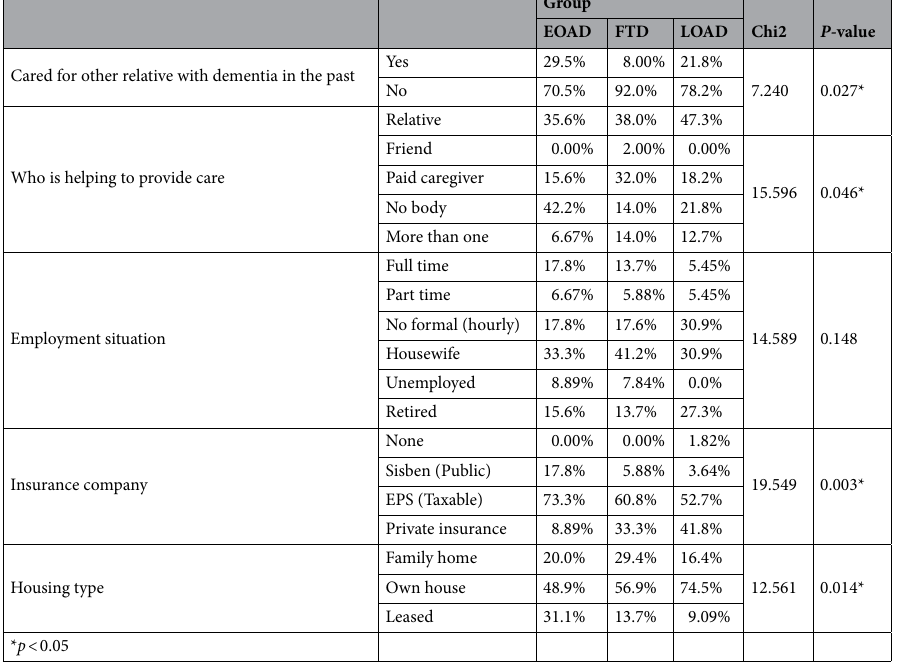
Table 2. Socioeconomic characteristics among EOAD. FTD. and LOAD dementia